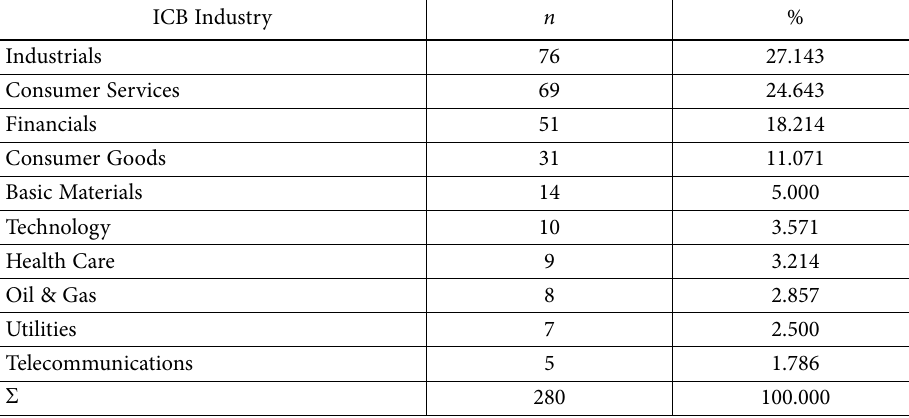
Table 1. Scope of activities of the companies investigated ICB